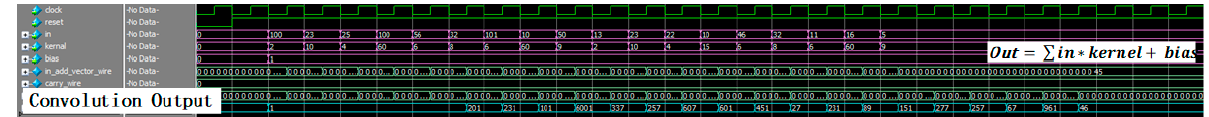
Figure 15. The simulation result of the top convolutional layer.